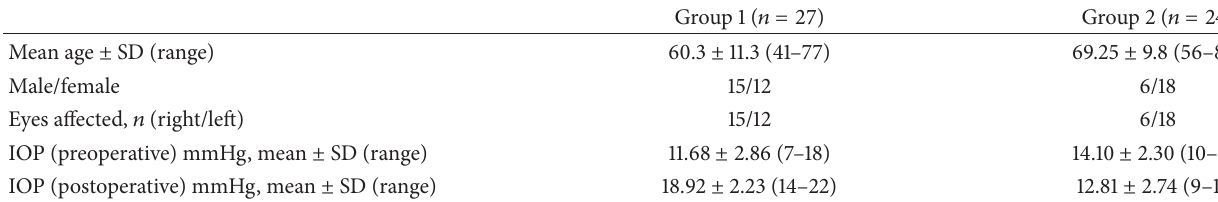
Table 1: Demographic and clinical characteristics of the groups.